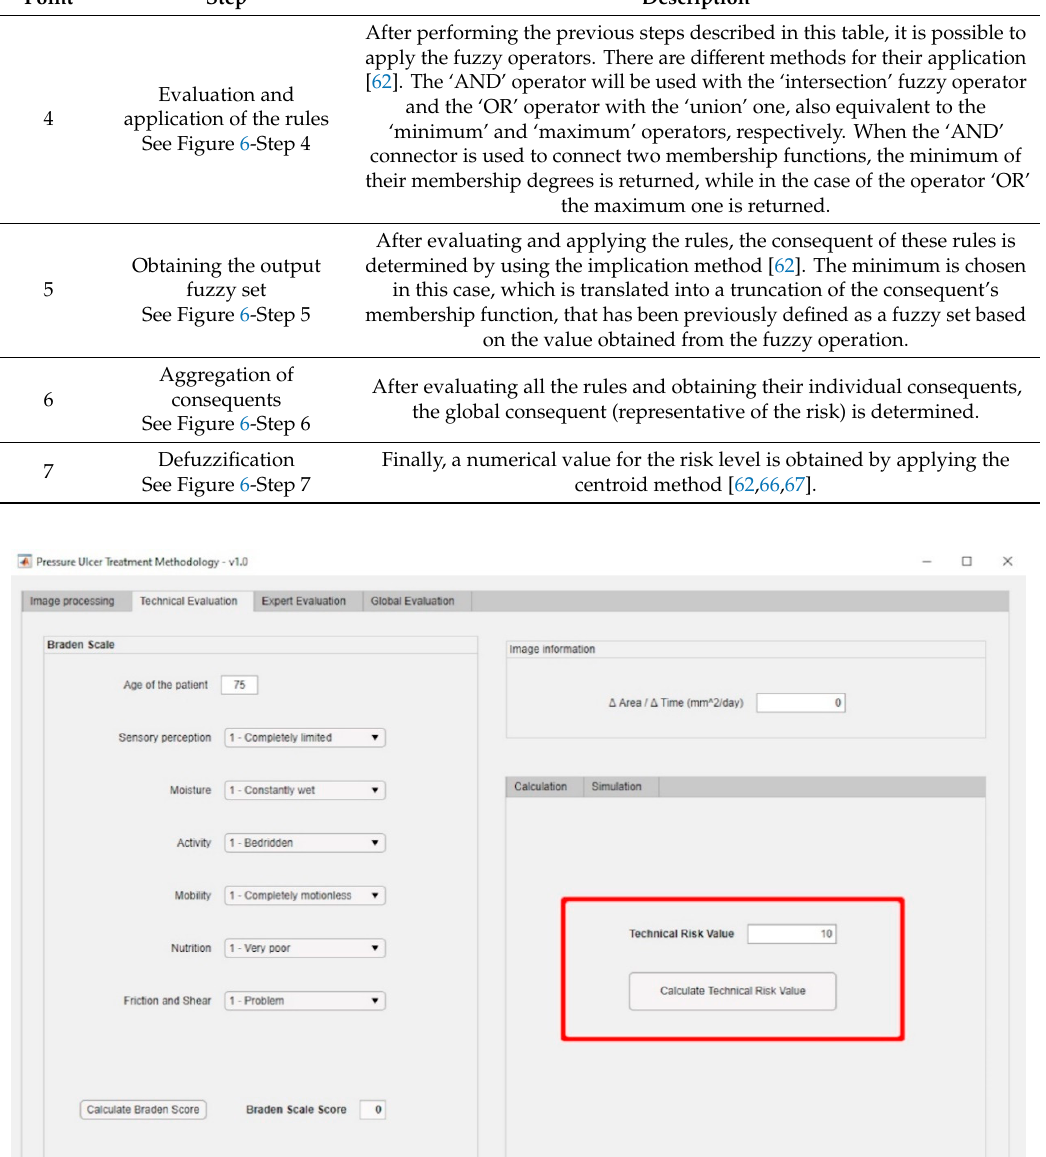
Figure 7. Technical Risk management panel.